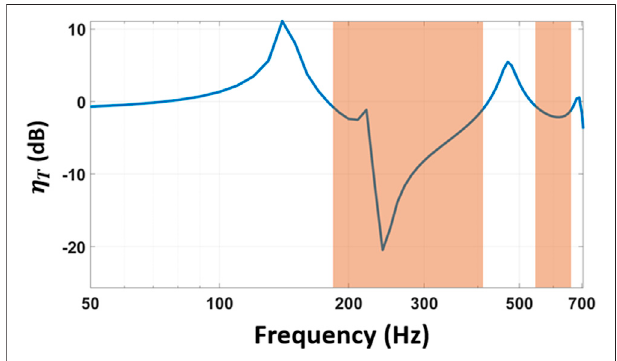
FIGURE 7 | Transmissibility of the layered metamaterial vibration attenuation structure obtained using model simulations. The fi rst bandgap (190 – 410 Hz) and the second bandgap (550 – 710 Hz) are shown in the shaded regions.